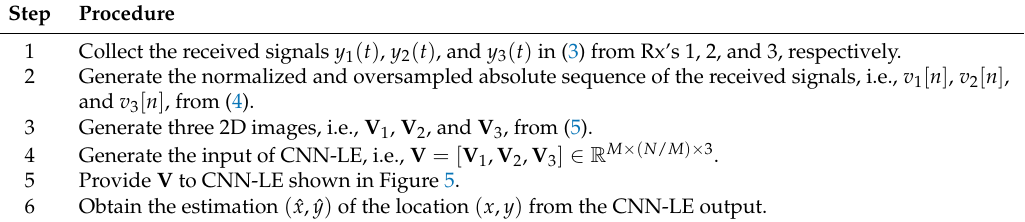
Figure 4. Example of the input for CNN-LE training. Here, the input sequence vectors v 1, q , v 2, q , and v 3, q shown in ( a ) are generated from the received signals of Rx-1, Rx-2, and Rx-3, respectively. Each sequence has a length of 14,400, i.e., N = 14,400. ( b ) Three-channel input images, namely, V 1, q ∈ R 120 × 120 , V 2, q ∈ R 120 × 120 , and V 3, q ∈ R 120 × 120 , are the input of the proposed CNN-LE, where M = 120. Table 2. Procedure of the proposed CNN-LE localization (excluding the training procedure and the training index q is